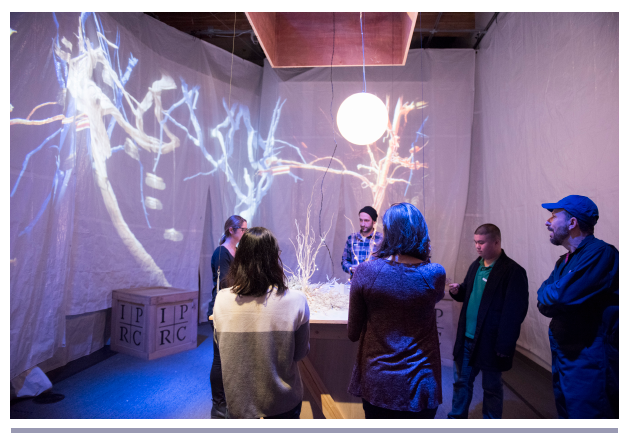
Fig. 7 . Leaf selection. (Photo by Emily